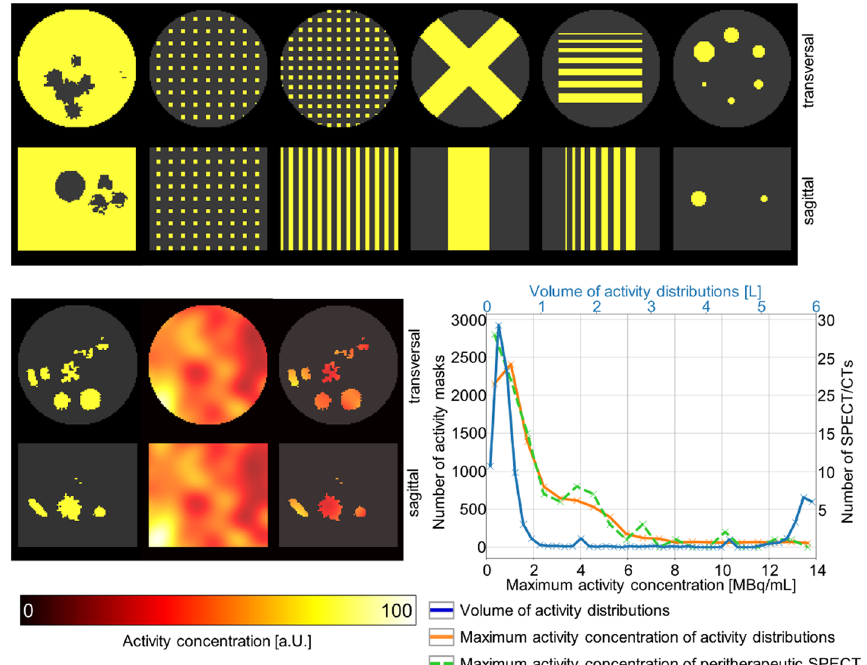
Fig. 3 Illustration of the activity mask dataset. For each activity mask, the transversal (top) and sagittal sections (bottom) are shown. First row from left to right: hot Jaszczak with cold random shapes, chessboard pattern, rod pattern, cross pattern, stripe pattern, NEMA phantom spheres. Second row from left to right: example random shape, example Fourier series F ( x , y , z ), random shape with non‑uniform activity distribution. The plot shows the distribution of the maximum activity concentration (orange, bottom and left axes) and volumes (blue, top and left axes) of the activity distributions contained in the dataset. The dashed green curve represents the distribution of the maximum activity concentration of 104 peritherapeutic 177 Lu SPECT/ CT examinations (bottom and right